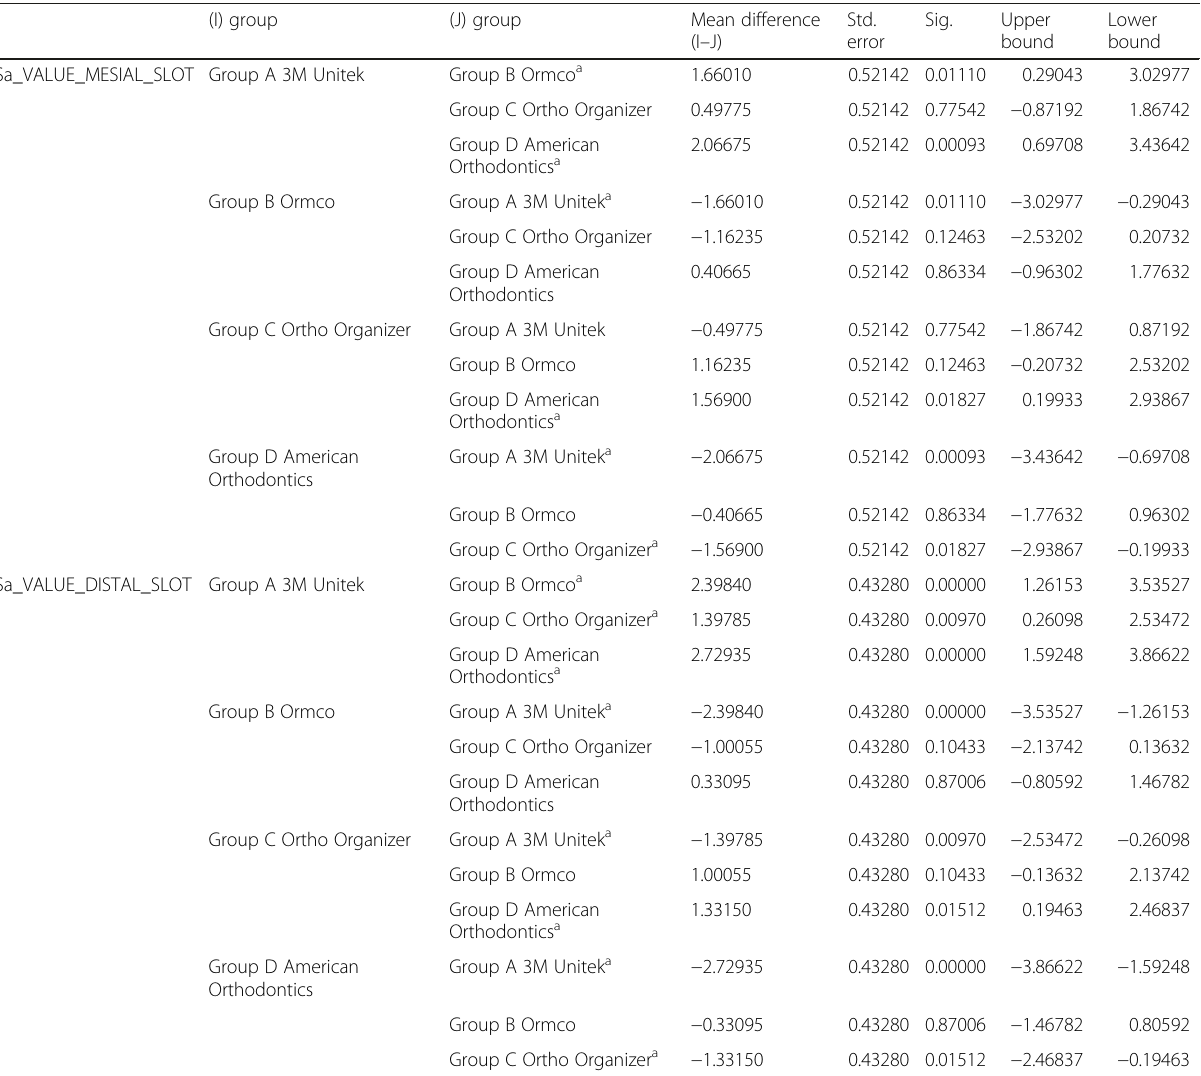
Table 2 Results of Tukey ’ s test for slot surface roughness